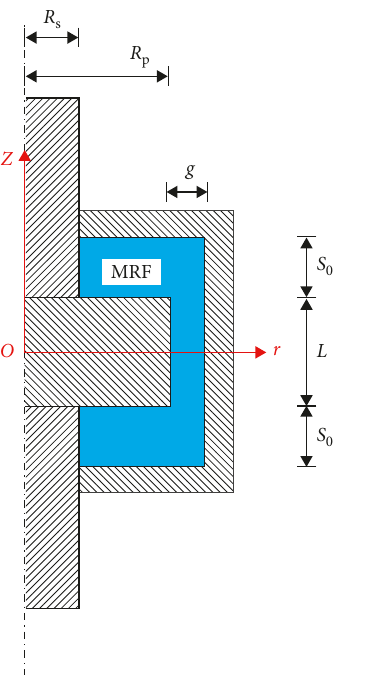
Figure 1: Typical configuration of a MR damper.